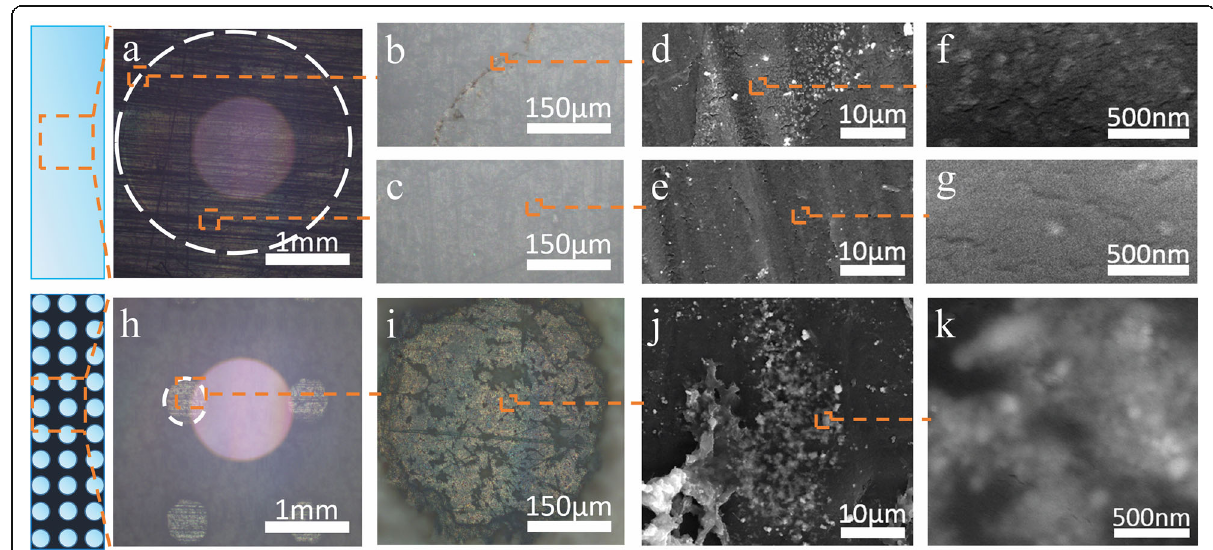
Fig. 3 a – c The optical microscope images and d – g the SEM images of Ag nanoparticles aggregation on the original PTFE with different multiples. h , i The optical microscope images and j , k the SEM images of Ag nanoparticles aggregation on the engraved PTFE with different multiples. The whole orange small boxes represent the magnified area and the white dotted line circles the finial area of Ag nanoparticles